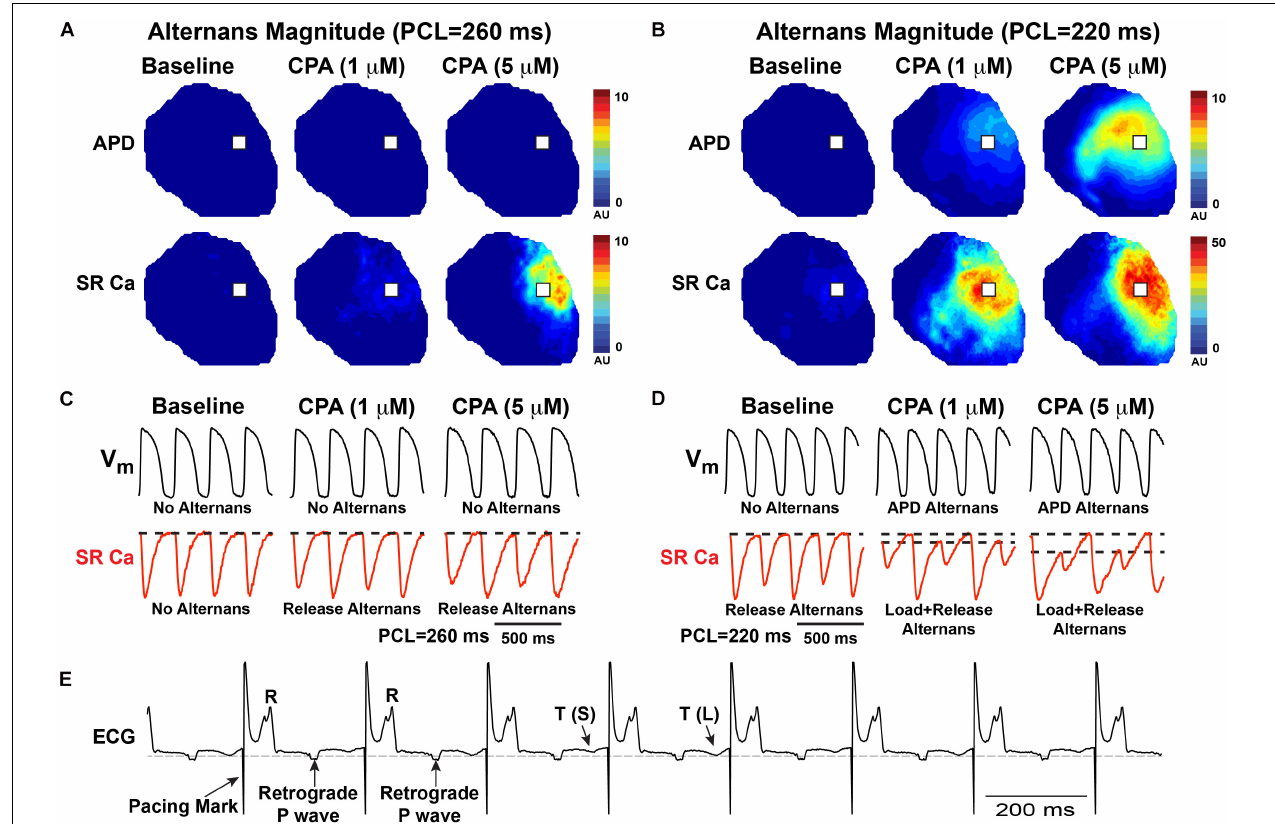
FIGURE 2 | Both action potential duration (APD) and sarcoplasmic reticulum (SR) Ca 2 + alternans progressively worsen with increased pacing frequency as shown by the alternans magnitude maps (A,B) and in example optical traces (C,D) from the location indicated with a white box in (A,B) . In this example, cyclopiazonic acid (CPA) (1–5 µ M) caused a dose-dependent increase in the magnitude of SR Ca 2 + and APD alternans and an increase in the pacing cycle length (PCL) at which alternans occurred. (E) Example ECG showing T-wave alternans—small (S) vs. large (L)